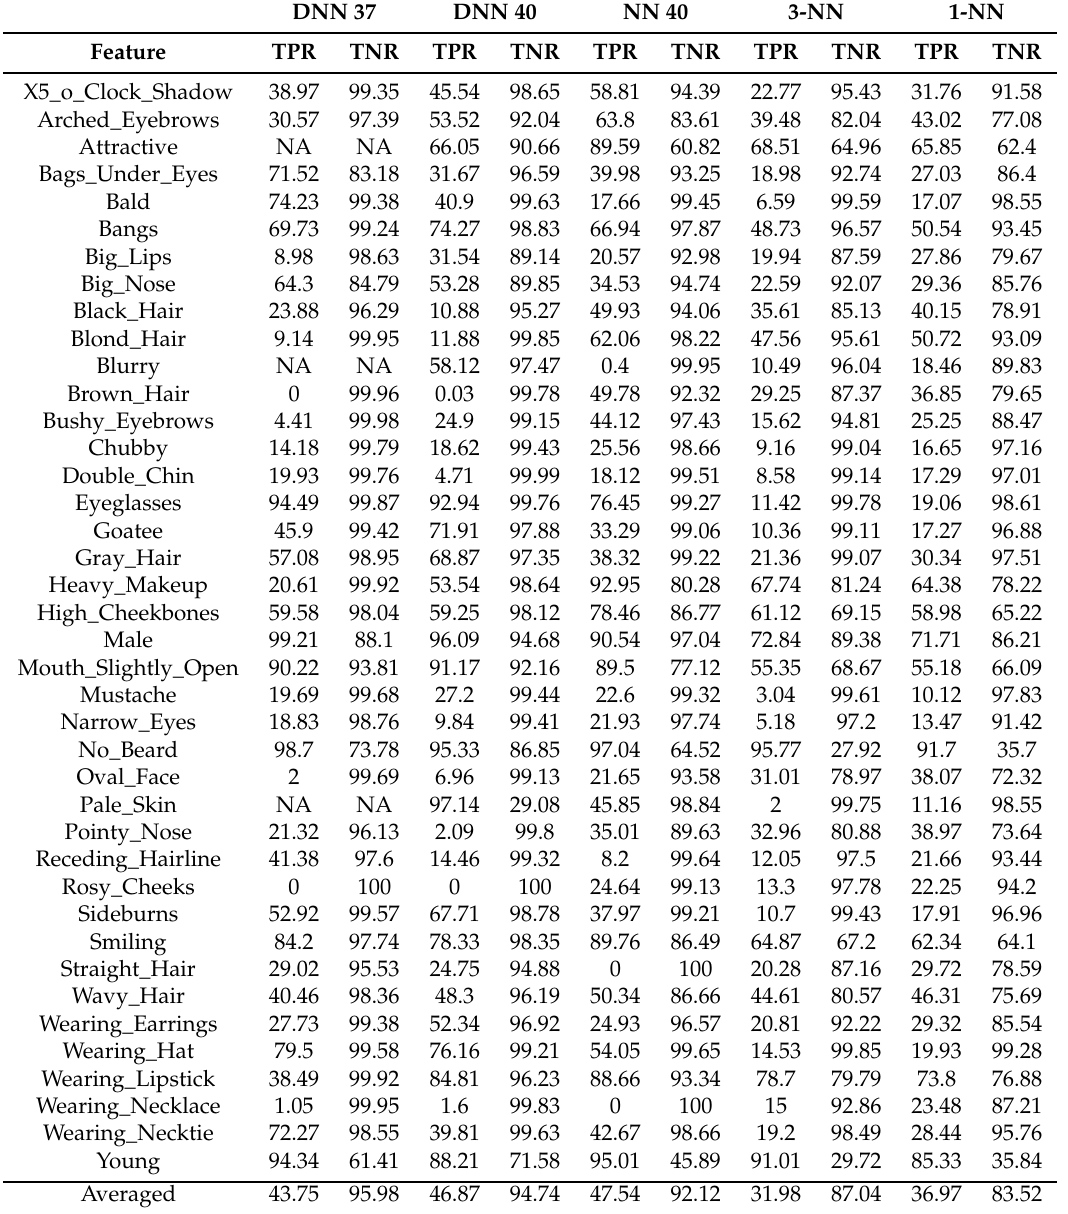
Table 4. True positive rates (TPR) and true negative rates (TNR) of each classifier on each attribute (expressed in